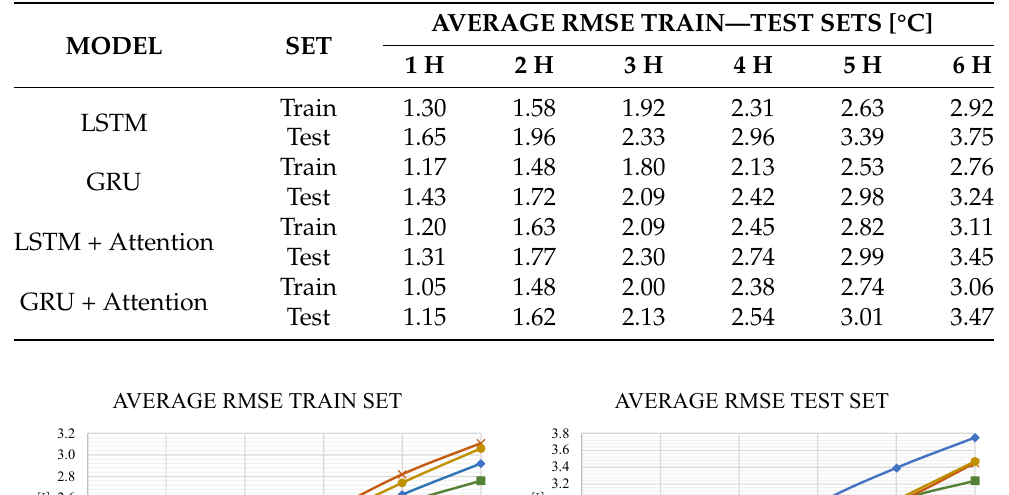
Table 1. Average RMSE results of the train and test sets for the four different deep learning models in 6 different times.